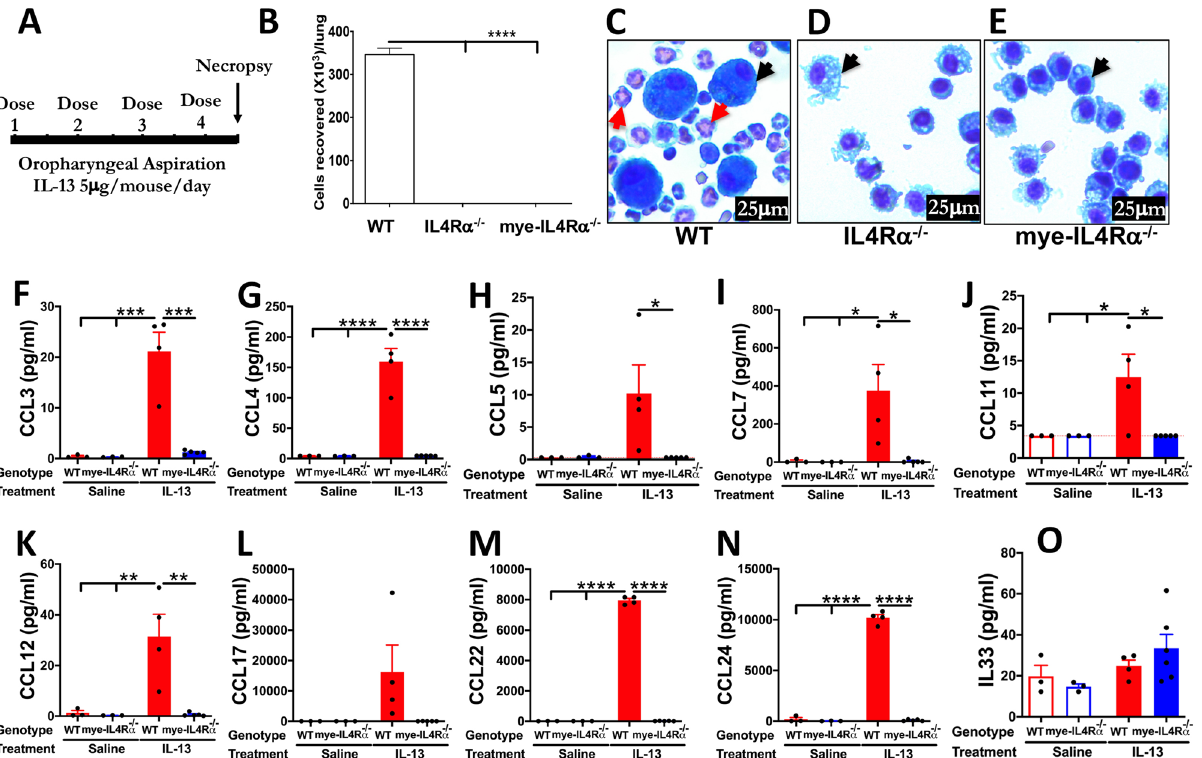
Figure 5. Myeloid-IL4Rα is essential for IL-13 and IL-5/eotaxin-induced lung eosinophilia and eosinophil chemoattractants are significantly reduced in the BALF of IL-13 treated mye-IL4Rα −/− versus IL-13 treated WT mice. Scheme for IL-13-induced lung eosinophilia ( A ). Total number of eosinophils recovered from IL-13 treated WT, IL4Rα −/− and mye-IL4Rα −/− mice (n = 4 per group) ( B ). Representative photomicrograph of BALF cytospins from IL-13-treated WT ( C ), IL4Rα −/− ( D ), and mye-IL4Rα −/− ( E ) mice (red arrows, eosinophils; black arrows, macrophages). Error bars represent SEM. * p < 0.05, ** p < 0.01, *** p < 0.001, **** p < 0.0001, using ANOVA followed by Tukey’s multiple comparison post hoc test. Cytokine levels (pg/ml) of CCL3 (MIP1α) ( F ), CCL4 (MIP1β) ( G ), CCL5 (Rantes) ( H ), CCL7 ( I ), CCL11 (Eotaxin 1) ( J ), CCL12 ( K ), CCL17 ( L ), CCL22 ( M ), CCL24 (Eotaxin 2) ( N ) , and IL-33 ( O ) in cell-free BALF from saline- or IL-13-treated WT and mye- IL4Rα −/− adult mice. The lower limit of detection for CCL3 (MIP1α), CCL4 (MIP1β), CCL5 (Rantes), CCL7, CCL11 (Eotaxin 1), CCL12, CCL17, CCL22, and CCL24 (Eotaxin 2) were 0.23 pg/ml, 4.0 pg/ml, 4.0 pg/ml, 0.27 pg/ml, 0.42 pg/ml, 3.41 pg/ml, 0.22 pg/ml, 5.03 pg/ml, 0.42 pg/ml, 0.60 pg/ml, and 4.06 pg/ml, respectively. The lower limit of detection for CCL5 (Rantes) and CCL11 (Eotaxin 1) are indicated by red dotted lines. Error bars represent SEM. * p < 0.05, ** p < 0.01, *** p < 0.001, **** p < 0.0001, using 2-way ANOVA followed by Tukey’s multiple comparison post hoc test. n = 3–5. Results in panels B-E are representative of three independent experiments. Data in panels F-O were generated using BALF from 3 to 5 independent